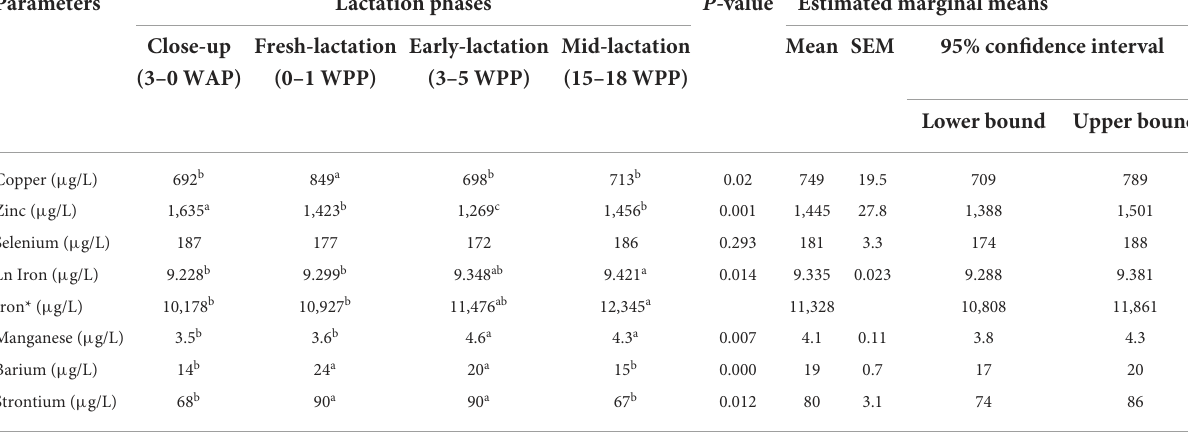
TABLE 1 Summary of the linear mixed model analysis for essential and accidental trace element concentrations in dairy cows at different production phases ( n =